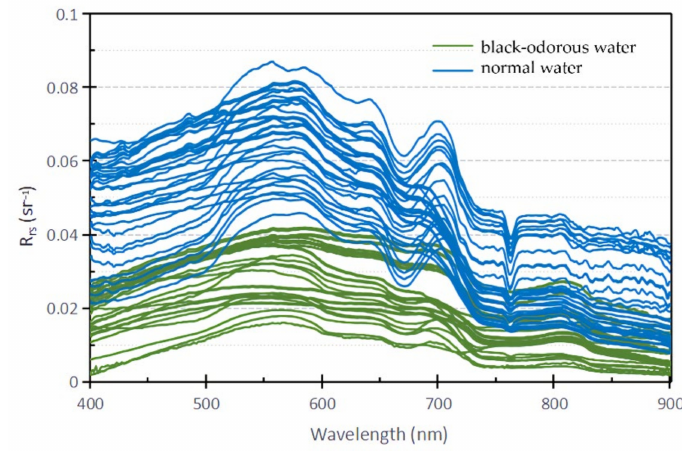
Figure 2. Reflectance spectra of black-odorous water and normal